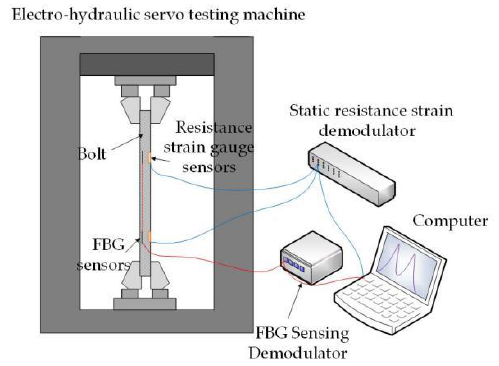
Figure 9. Schematic diagram of the test equipment